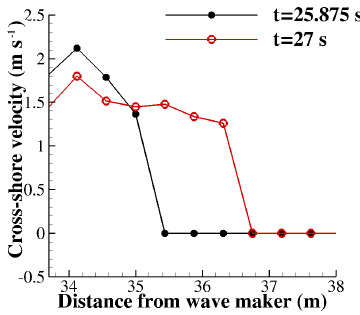
Figure 12. Velocity distribution in the bore near gauge A4, from the GeoClaw model.